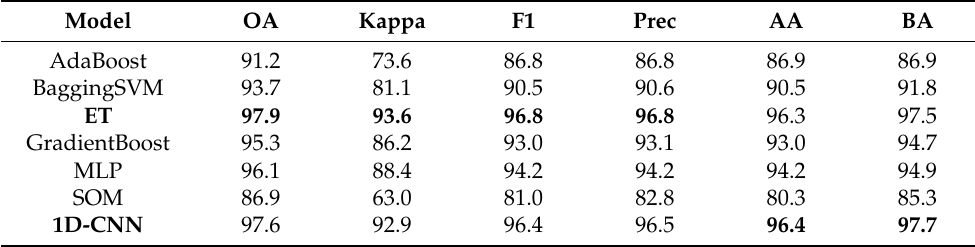
Table 5. Classification metrics in % of all ML models trained on Uset 3 and their prediction performed on Subset 2 and compared to the reference data. The 1D-CNN scores were calculated as the average of five runs. The bold values represent the best classification results, respectively. (OA: overall accuracy, Prec: precision, AA: average accuracy, BA: balanced